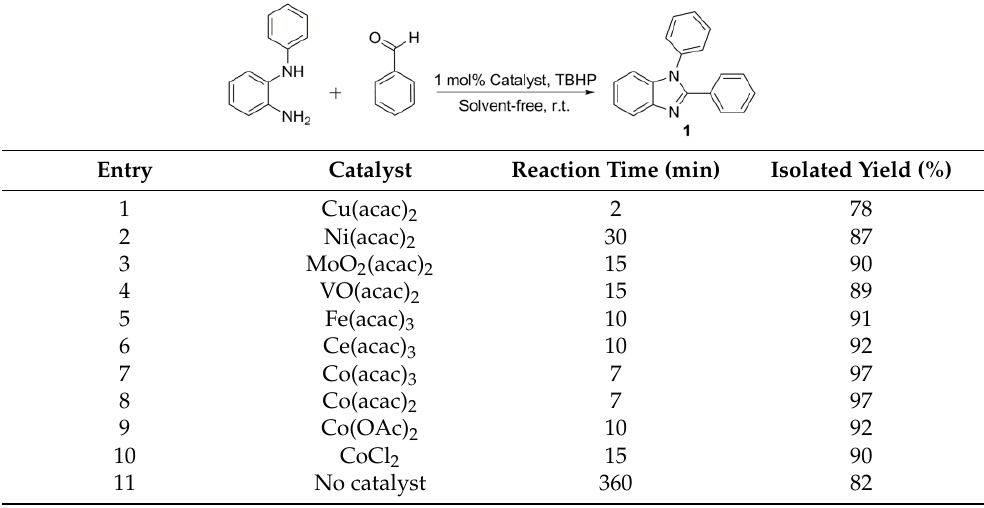
Table 2. The effects of multivalent transition metal catalysts on synthesis of 1 1 .